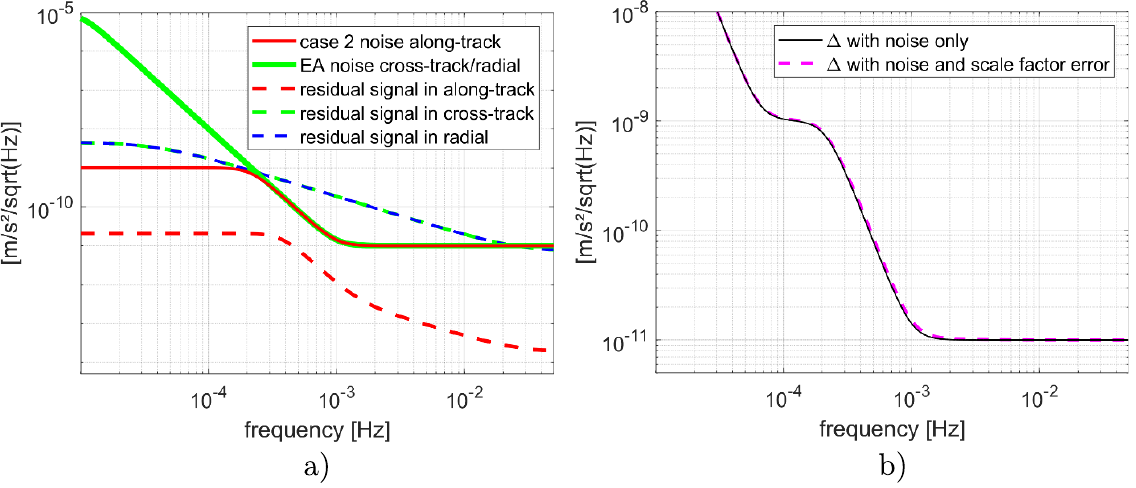
Figure 16. Retrieval error contributors with scale factor and instrument noise contributors, consider- ing a Case 2 1D-hybridized instrument ( a ) and the corresponding LOS projection ( b